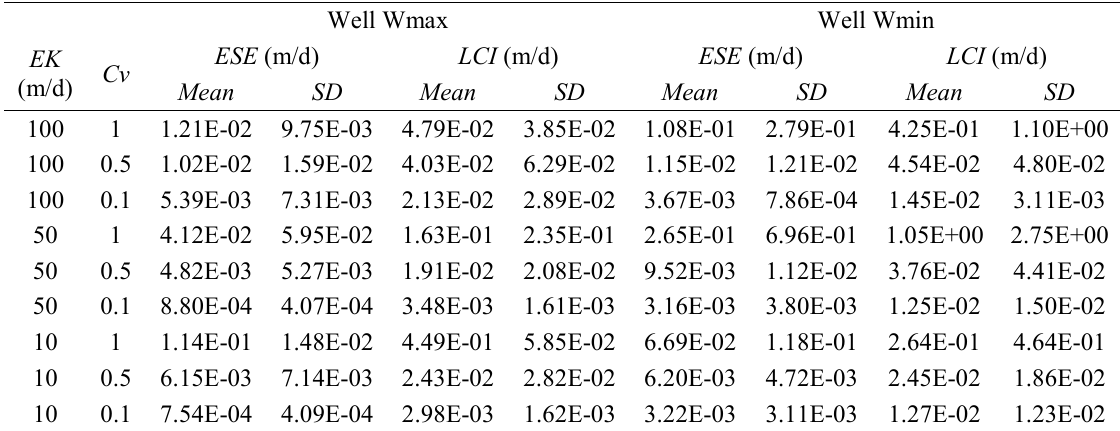
Table 1 The estimated standard error ( ESE ) and the length of confidence interval (LCI) (t 0.95 ) for two observation wells. Mean and SD represent the mean and standard deviation of results through 100 realizations at each EK and Cv value, respectively.